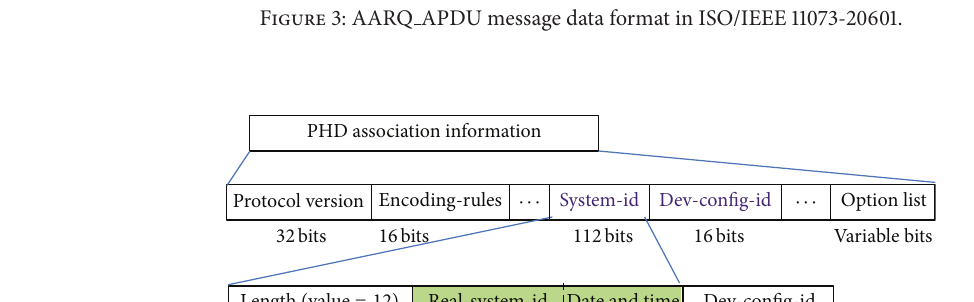
Figure 3: AARQ APDU message data format in ISO/IEEE 11073-20601.